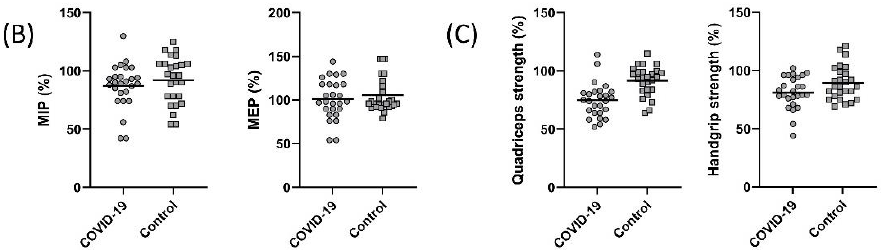
Figure 1. Comparison of ( A ) forced vital capacity (FVC) ( p = 0.005), percent predicted FVC ( p < 0.001), forced expiratory volume in one second (FEV 1 ) ( p = 0.04), percent predicted FEV 1 ( p = 0.001), FEV 1 /FVC ( p = 0.255), peak expiratory flow (PEF) ( p = 0.01), percent predicted PEF ( p = 0.007), forced